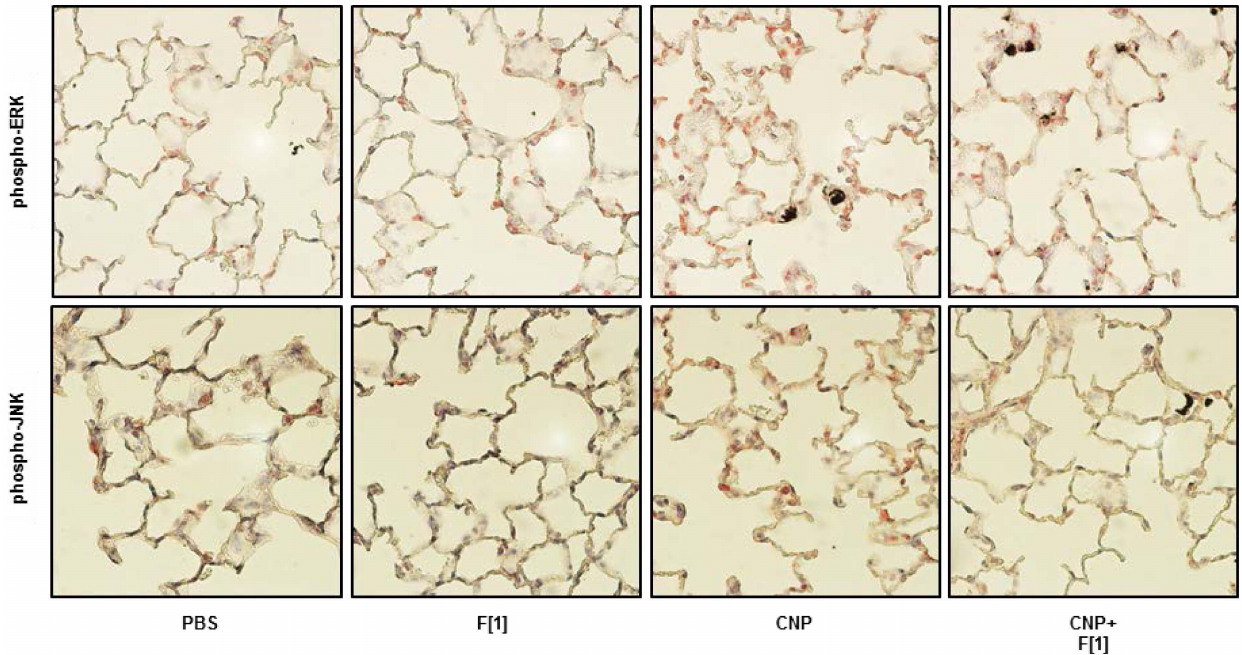
Figure 2. Particle-induced Activation of MAPK Is Blocked by Firoin. Female Fischer 344 rats were exposed to 2.5 mg/kg CNP in the presence or absence of 1 mM firoin (see fig. 3A). Phoshpo-Erk1/2 and phospho-JNK1/2 signals were stained (red) in 2 m m paraffin-embedded lung sections taken from animals 48 h after